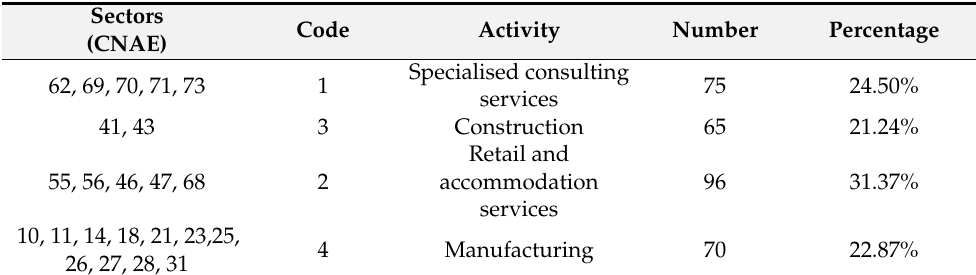
Table 2. Sector and activity of the companies